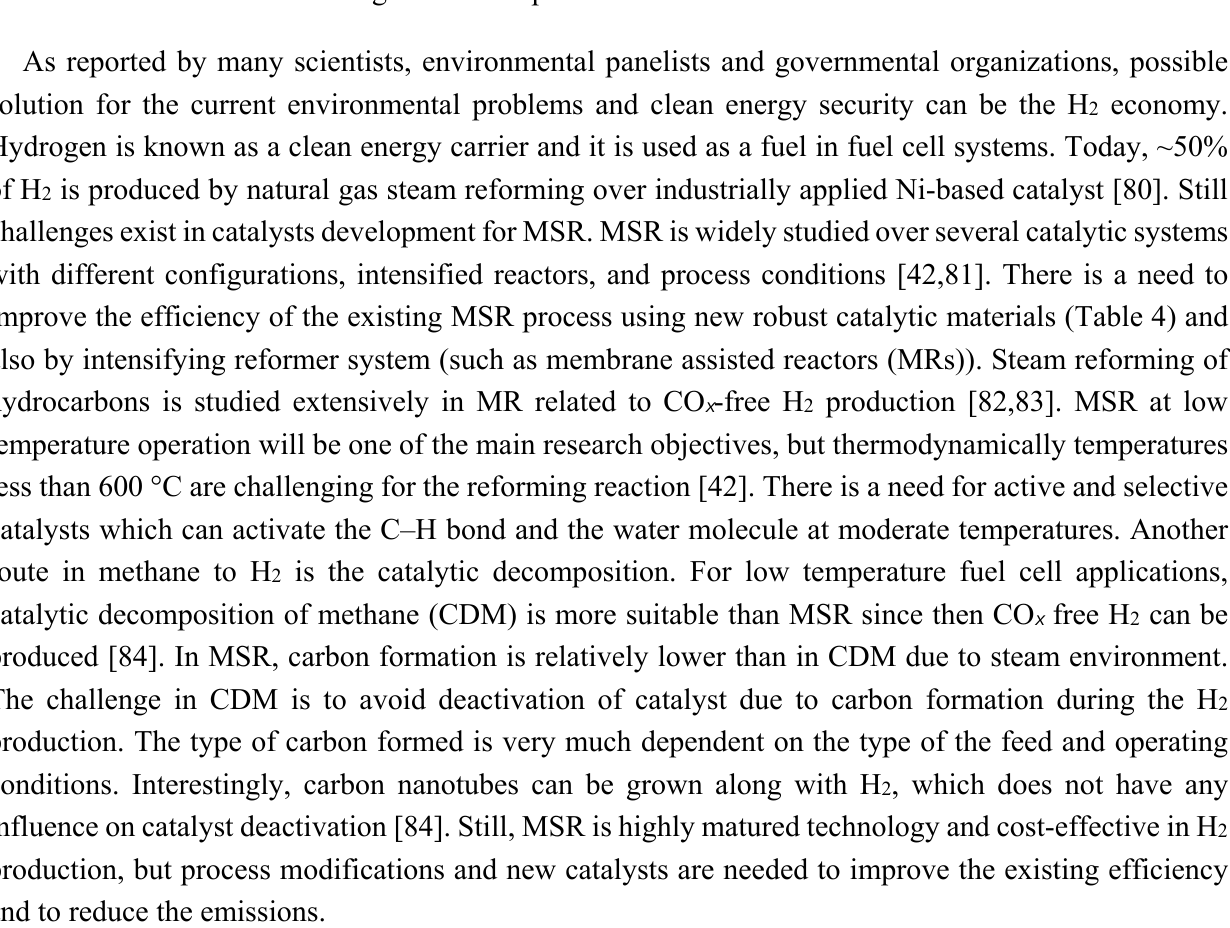
Table 4. Recently studied catalysts in methane steam reforming to hydrogen.